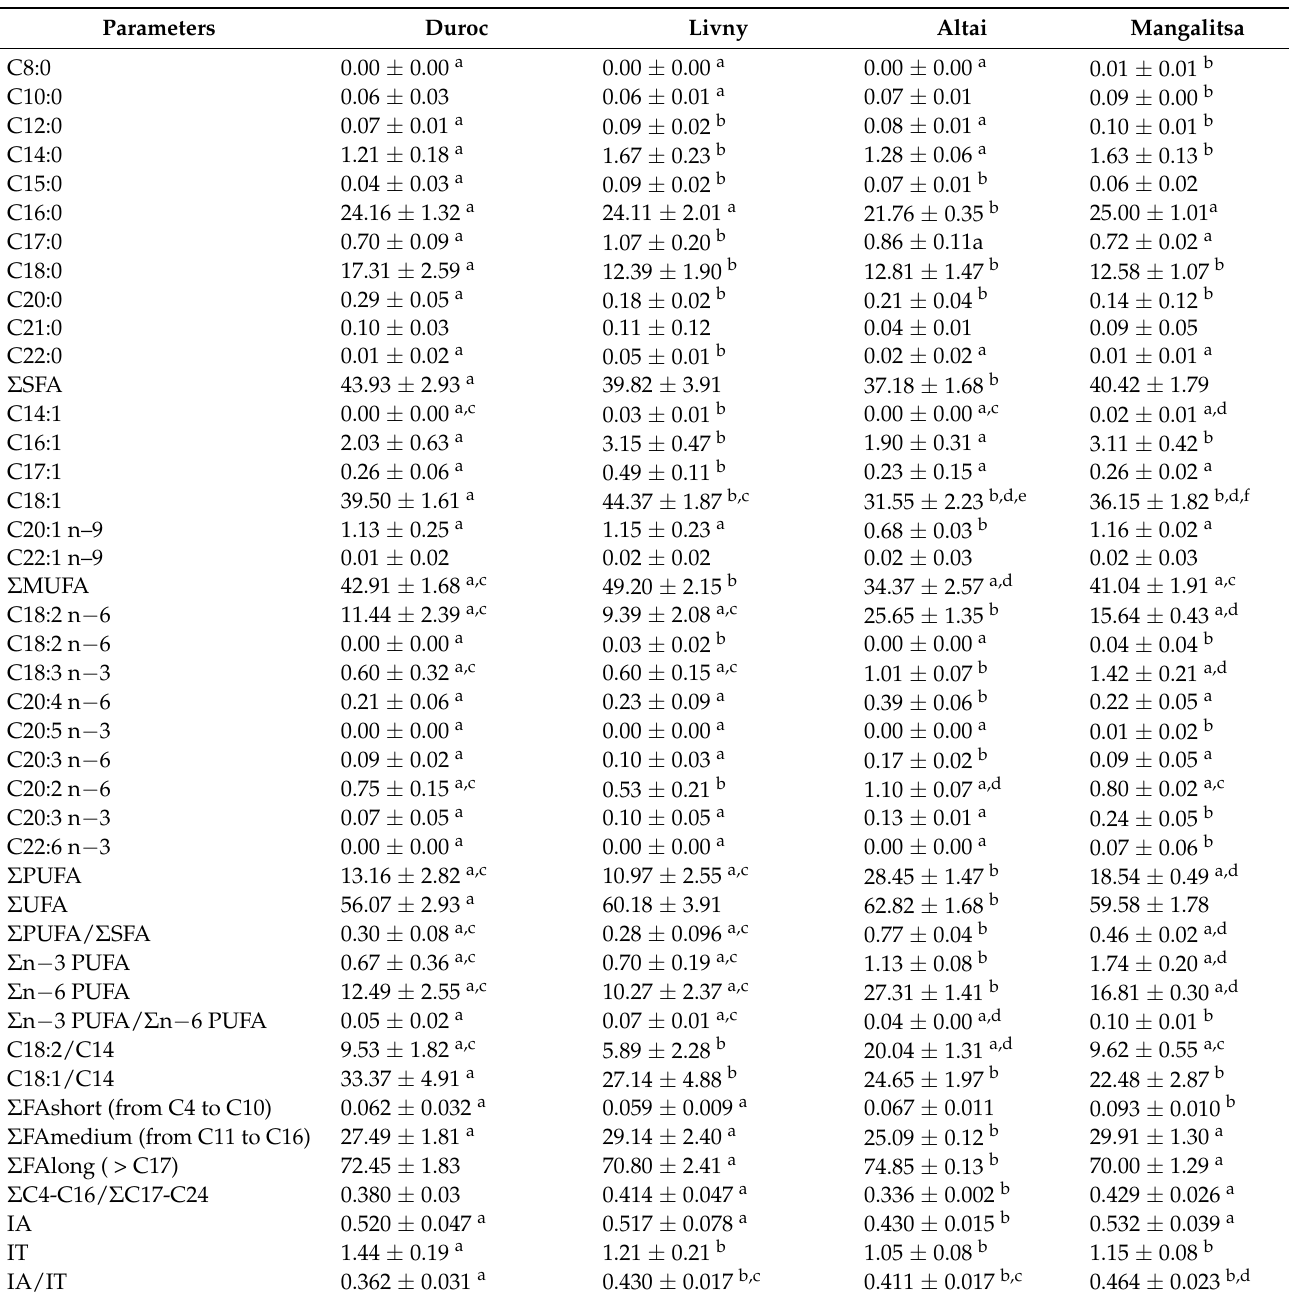
Table 2. Results of fatty acid composition (mass fraction, % of total fatty acids) of backfat samples of different species (Mean ±